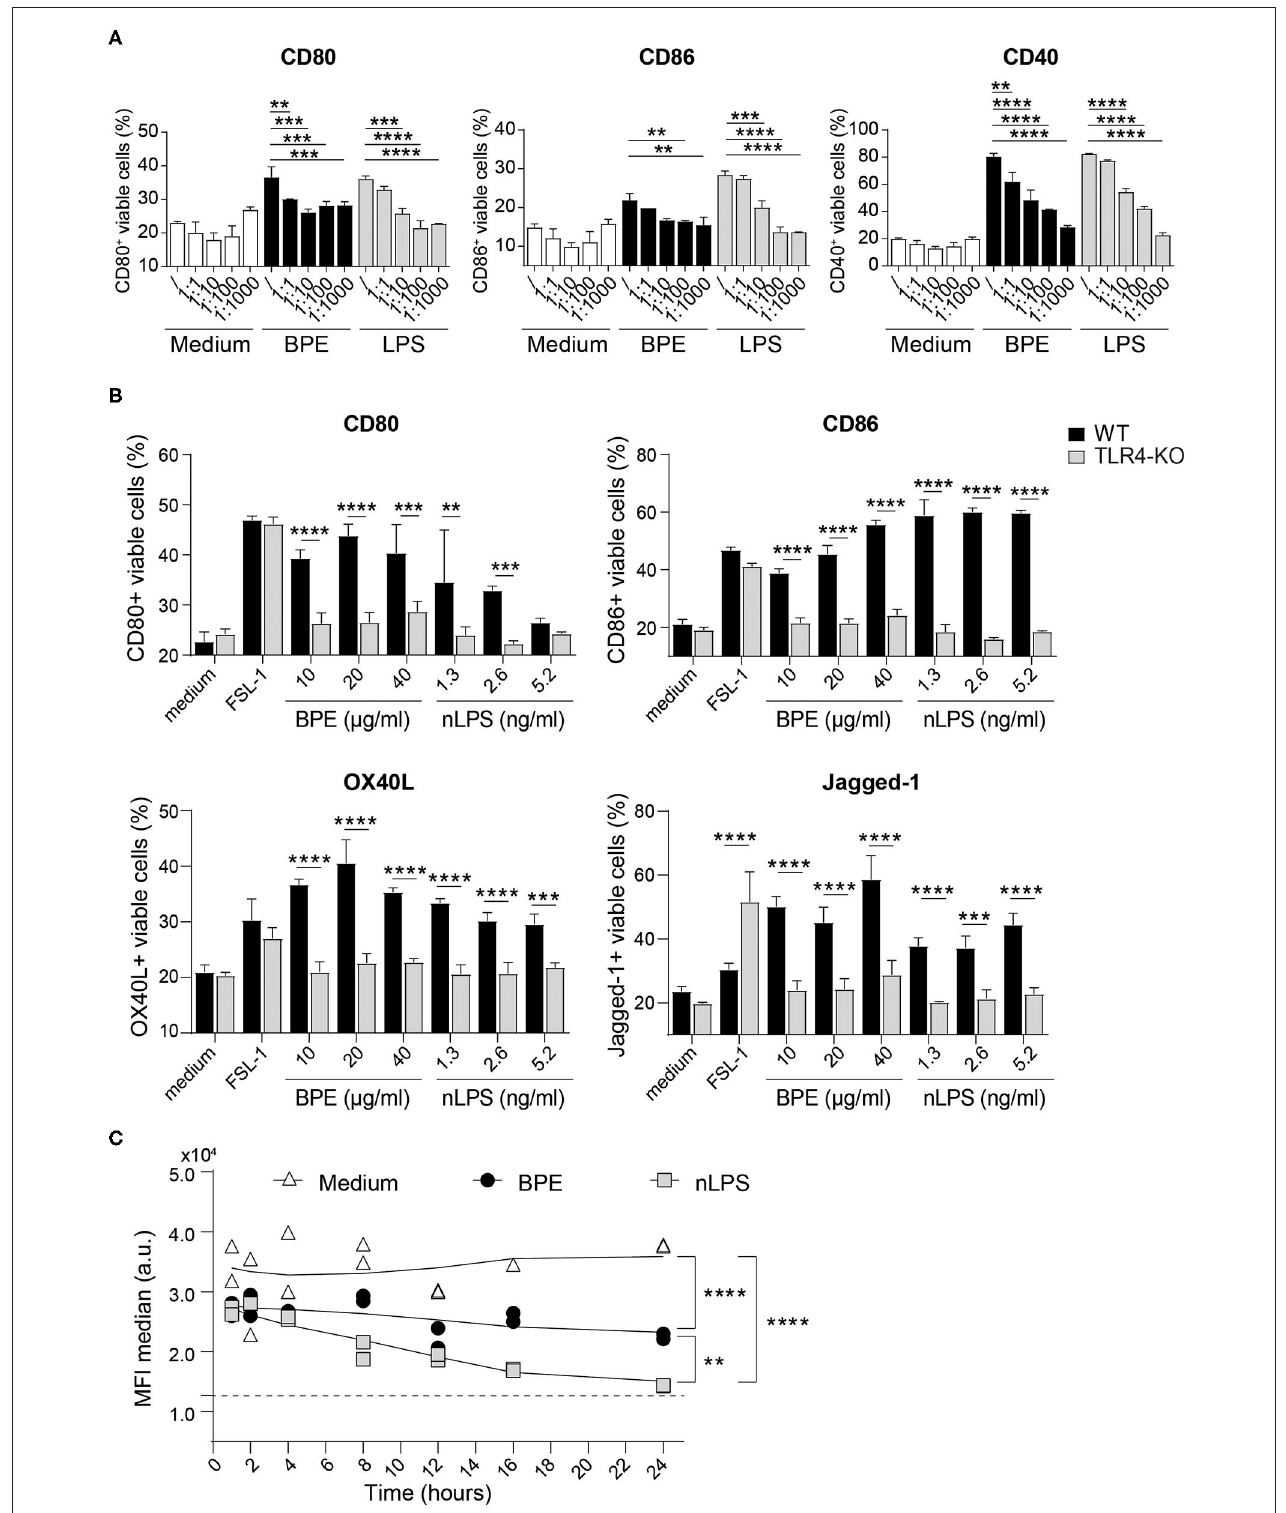
FIGURE 4 | BPE-induced BMDC activation is TLR4-dependent. Surface expression of the co-stimulatory molecules CD80, CD86, and CD40 was analyzed in Balb/c BMDCs pretreated with different concentrations of the TLR4 antagonist, ultra-pure LPS-RS, before stimulation with 60 µ g/ml BPE, the corresponding nLPS